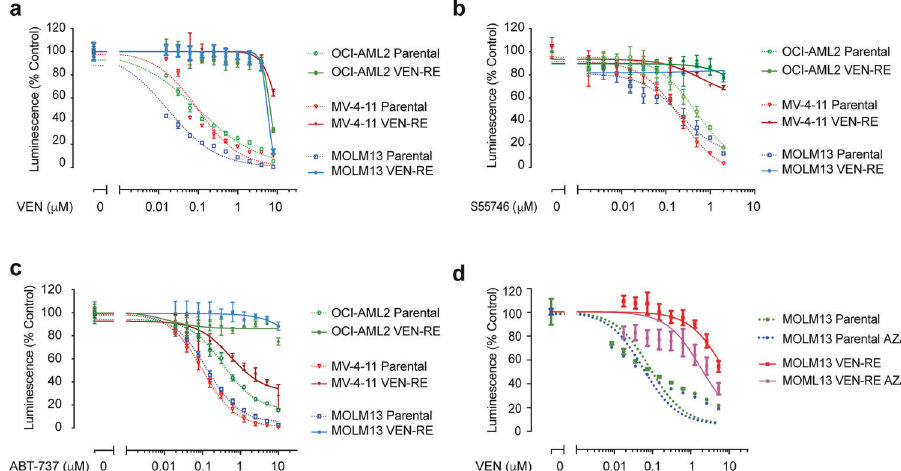
Fig. 1 Venetoclax-resistant (VEN-RE) cells had hypermethylated genomes. a – d The indicated parental cells (dotted lines) and VEN-RE cells (solid lines) were treated with the indicated inhibitors for 48 h, then cell viability was determined by CellTiter-Glo assay. Luminescence reads were normalized to those of DMSO-treated control cells. Data are mean ± SD. a Results of viability assays for cells treated with 0 – 10 μ M VEN. b Results of viability assays for cells treated with 0 – 2 μ M of the BCL-2 inhibitor S55746. c Results of viability assays for cells treated with 0 – 10 μ M of the BCL-2/BCL-XL inhibitor ABT-737. d Viability of MOLM-13 parental and VEN-RE exposed to AZA and subsequently treated with 0 – 10 μ M